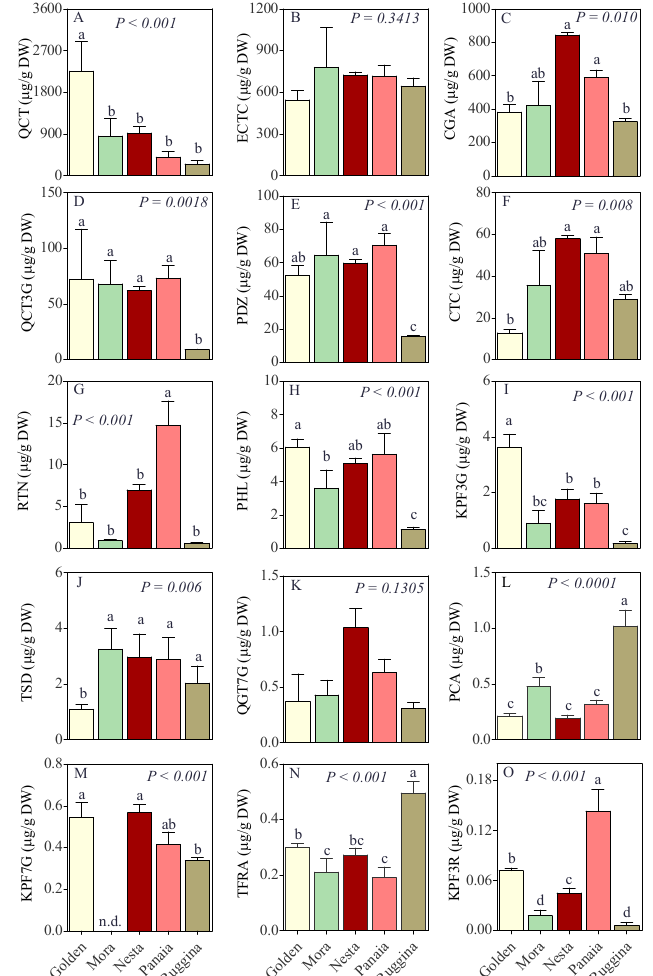
Figure 1. Mean values and standard deviation for the concentration ( g/g DW) of ( A ) quercetin (QCT), ( B ) ( − )-epicatechin (ECTC), ( C ) chlorogenic acid (CGA), ( D ) quercetin 3- O -glucoside (QCT3G), ( E ) phloridzin (PDZ), ( F ) (+)-catechin (CTC), ( G ) rutin (RTN), ( H ) phloretin (PHL), ( I ) kaempferol 3- O -glucoside (KPF3G), ( J ) tiliroside (TSD), ( K ) quercetagetin 7- O -glucoside (QGT7G), ( L ) p -coumaric acid (PCA), ( M ) kaempferol 7- O -glucoside (KPF7G), ( N ) trans -ferulic acid (TFRA), and ( O ) kaempferol 3- O -rutinoside (KPF3R), determined by UHPLC-ESI-MS/MS for dry apples. Data ( n = 3) were analyzed by one-way ANOVA. Different letters are significantly different according to Tukey’s post-hoc test at the 0.05 probability level.